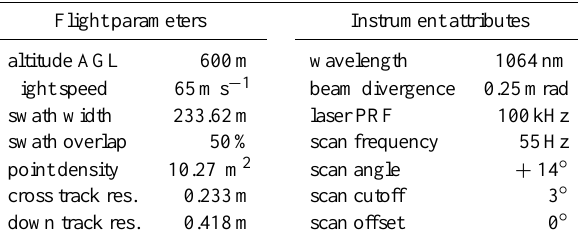
Table 1. Target parameters and attributes for LiDAR flights. Flight parameters Instrument attributes altitude